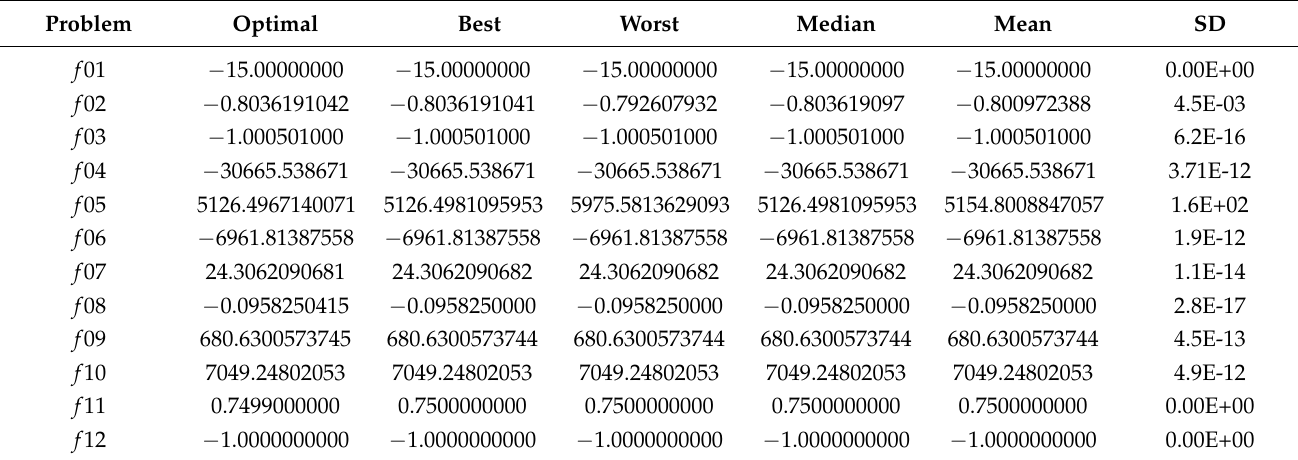
Table 2. The results of PSO-DE algorithm in the benchmark functions.